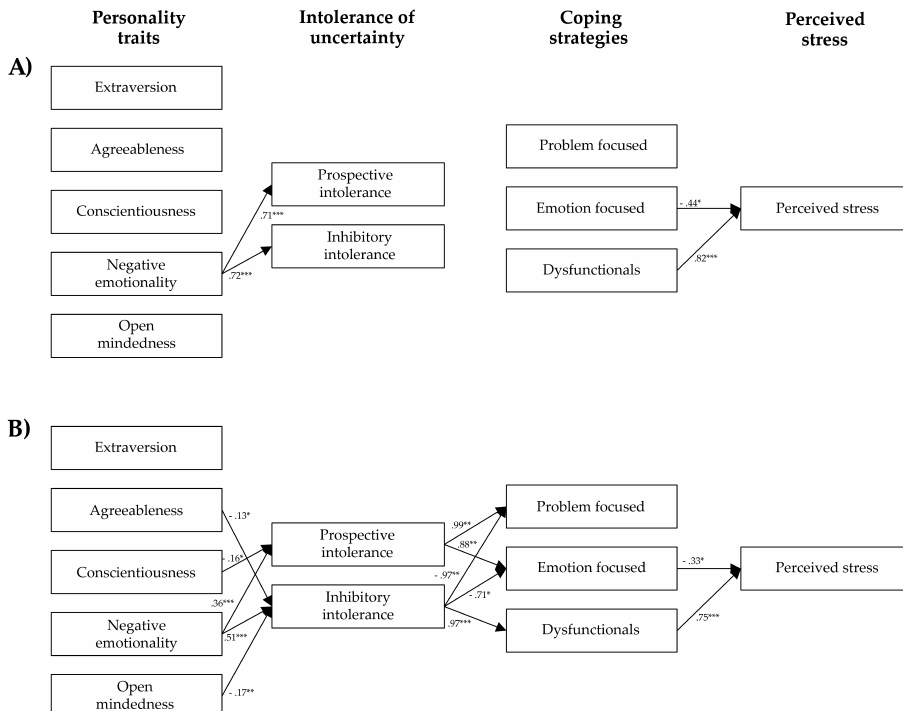
Figure 5. Structure of relations in the: ( A ) Frontline group of Italian HCWs; ( B ) non-frontline group of Italian HCWs. Signif. codes: 0 “***” 0.001, “**” 0.01, “*” 0.05, “.”